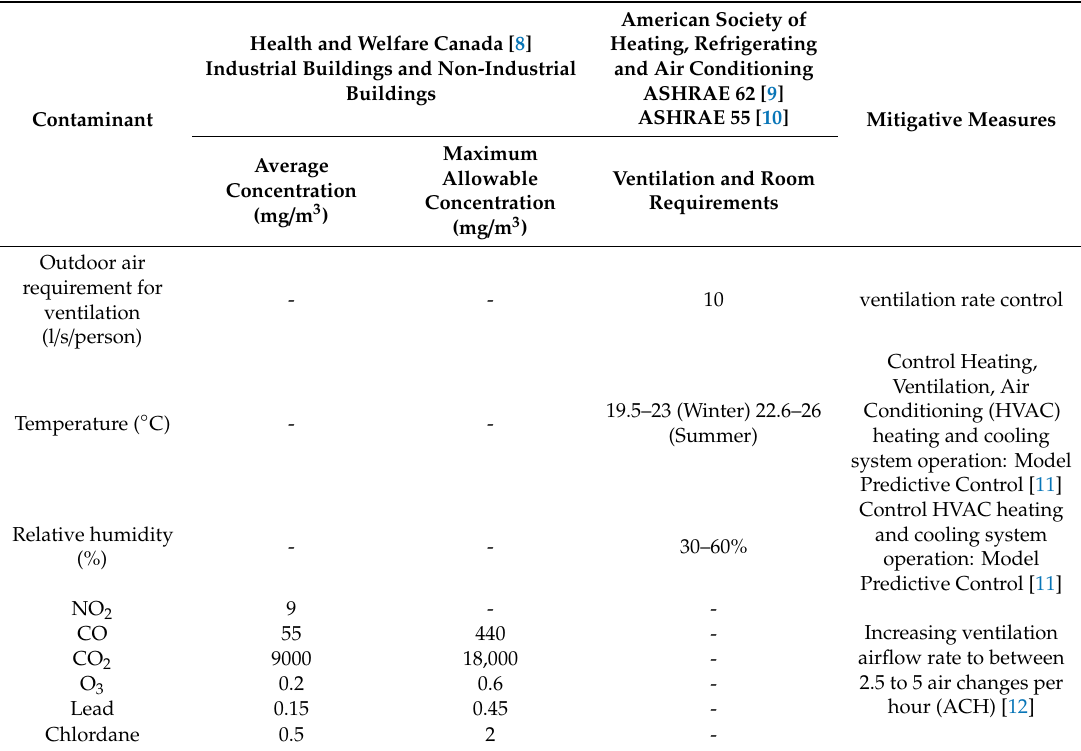
Table 1. Indoor environmental quality (IEQ)